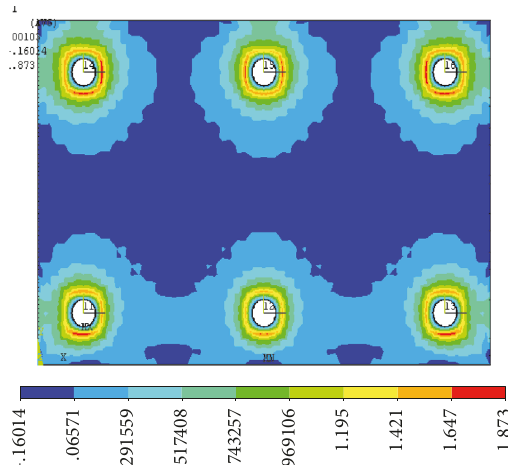
Figure 2: Principal tensile stress when the displacement resulting from the corrosion-induced expansion reaches 0.001mm.